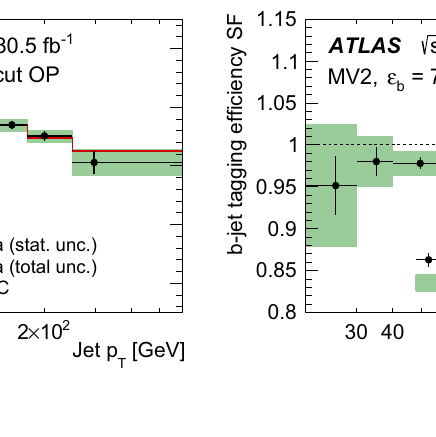
passing the signal region selection. Vertical error bars include data sta- tistical uncertainties only while the green bands correspond to the sum in quadrature of statistical and systematic uncertainties. The dots are located at the mean of the b -jet p T distribution in each p T